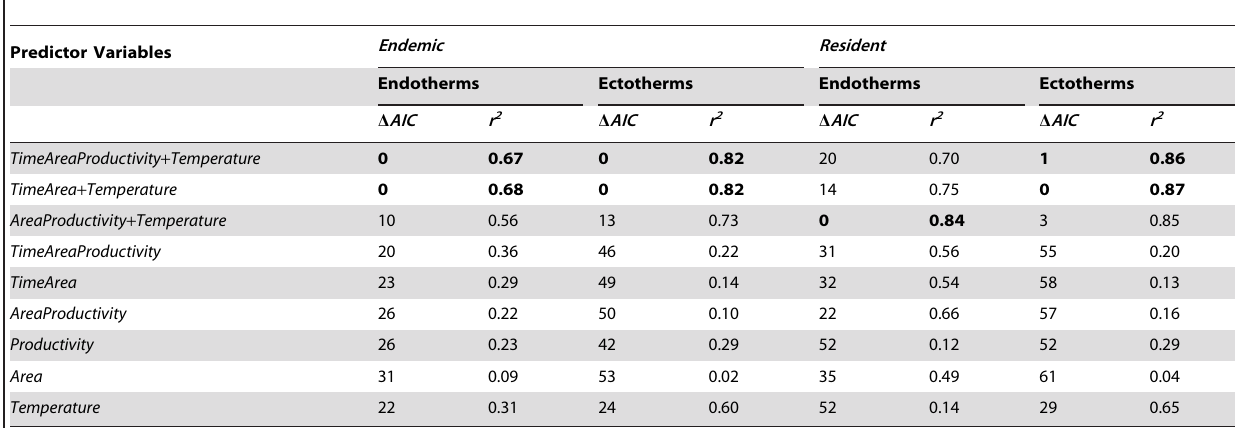
Table 1. Relative performance of integrated single- and two-predictor models of bioregion species richness.